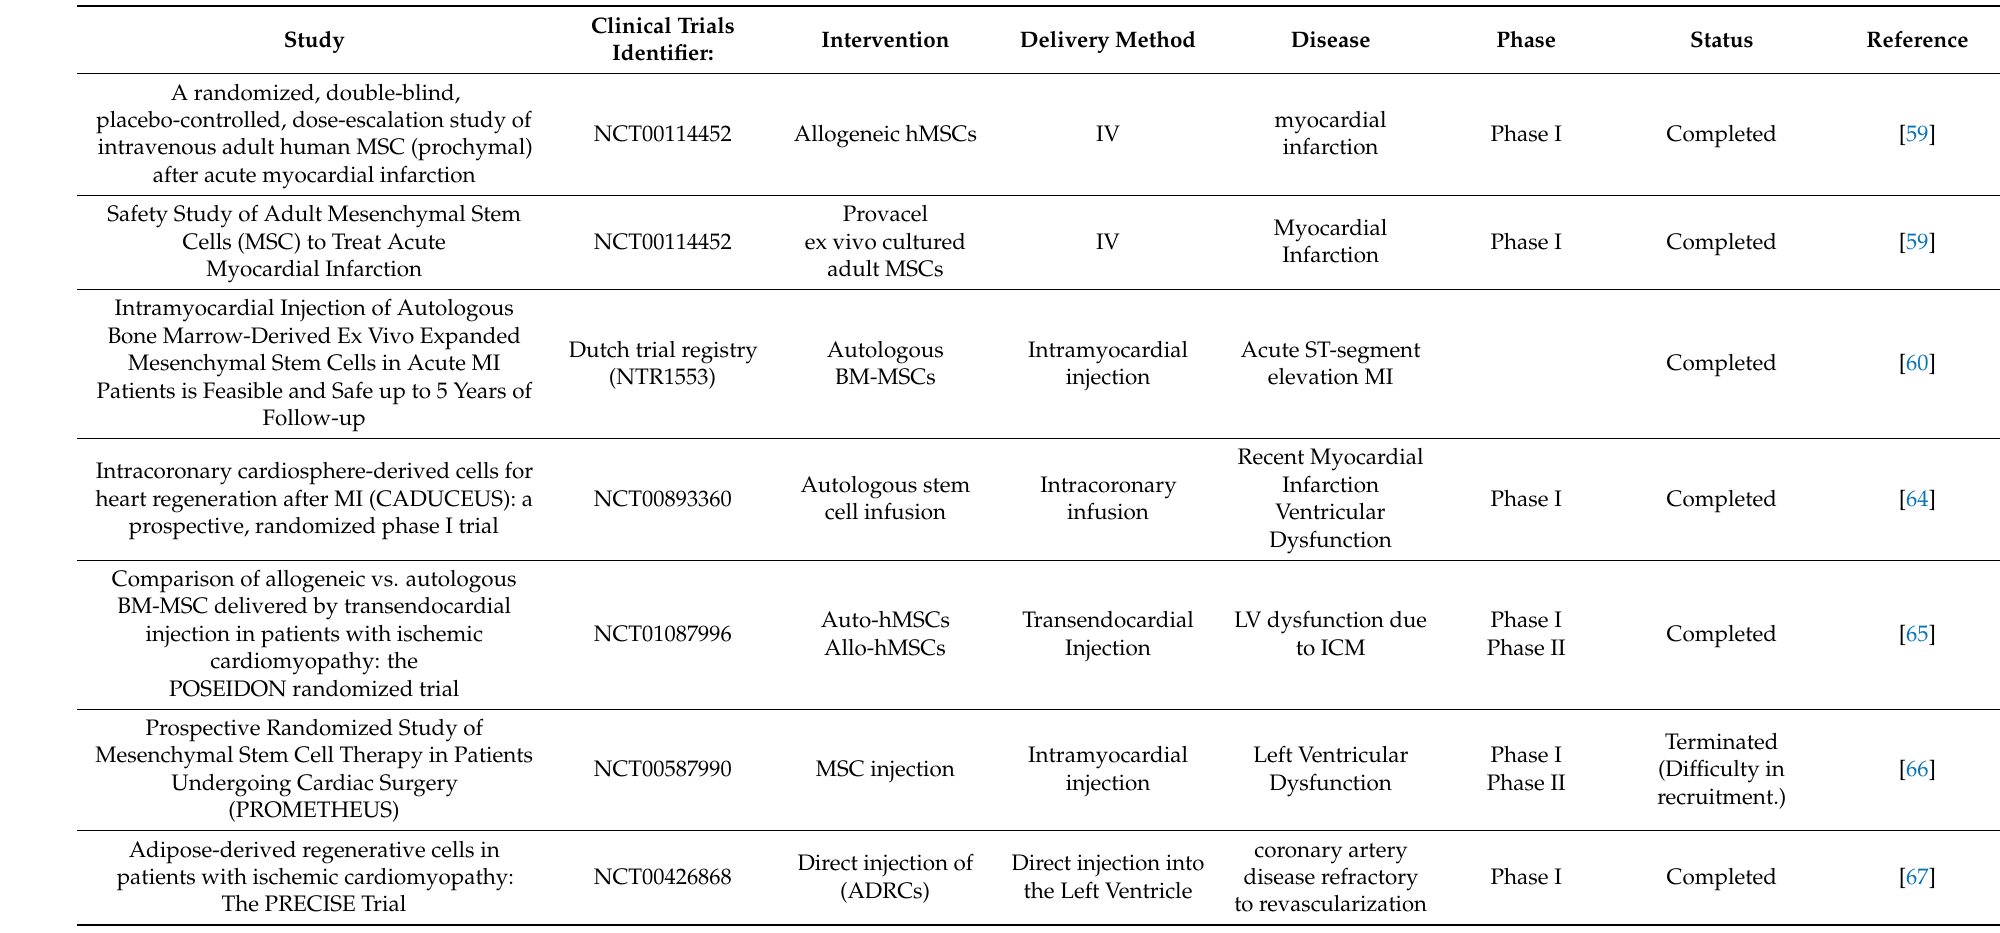
Table 1. Clinical Trials that utilized MSCs in ischemic heart